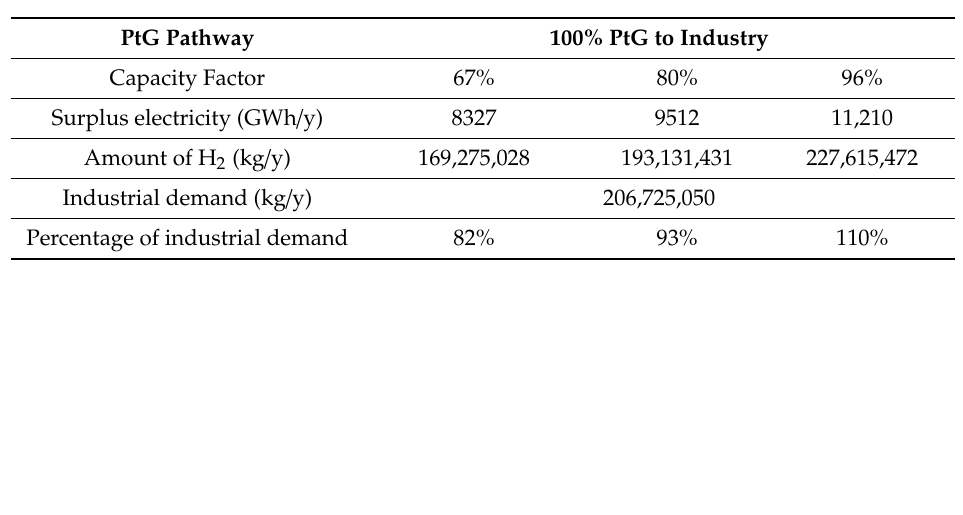
Table 9. Hydrogen allocation, Scenario